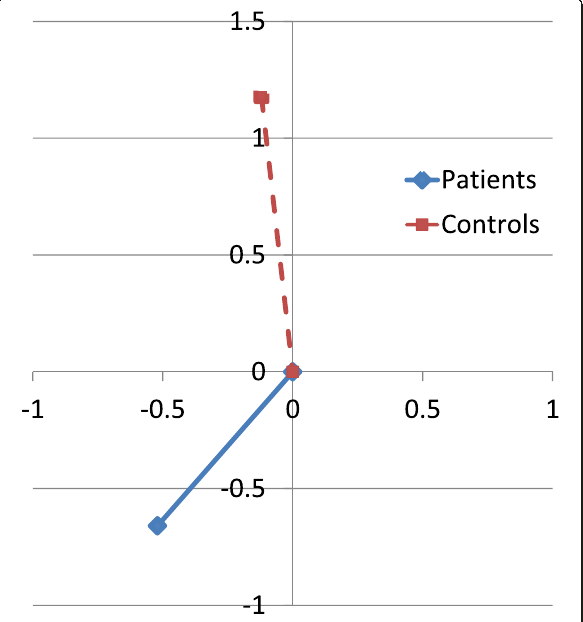
Fig. 2 Change in Co (mm) from initial records (T1) plotted at (0,0)